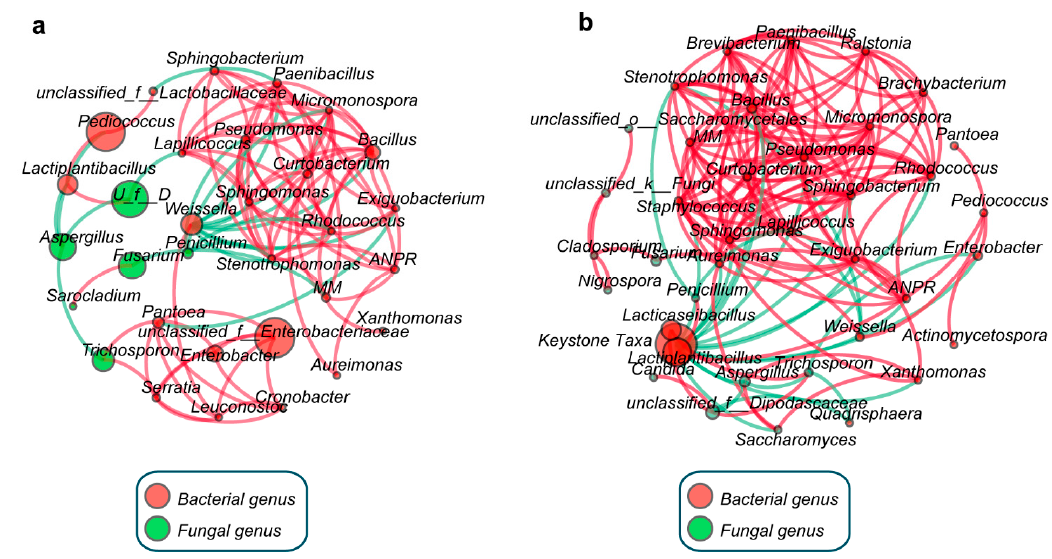
Figure 3. Network analysis showing the co-occurrence based on the correlation among dominant taxa. The control group ( a ); the Lactiplantibacillus plantarum inoculation group ( b ). Red edges: Positive correlation; green edges: Negative correlation; the size of nodes indicates the average relative abundance of the genera. U_f__D , unclassified_f__Dipodascaceae ; MM , Methylobacterium-Methylorubrum ; ANPR , Allorhizobium-Neorhizobium-Pararhizobium-Rhizobium . Keystone taxa include Lactiplantibacillus and Lacticaseibacillus